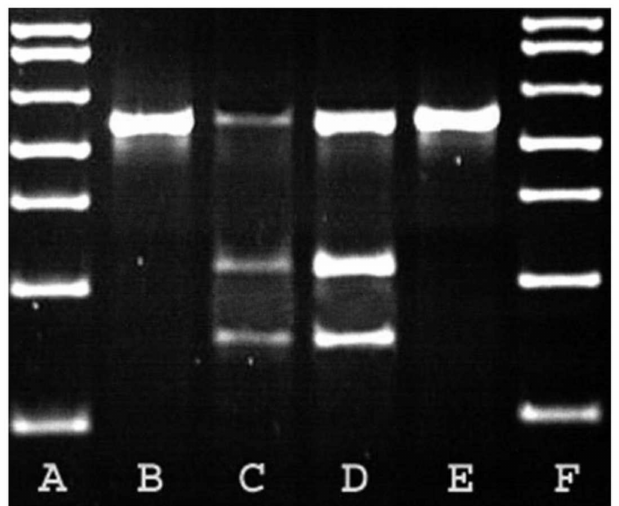
Figure 2. Restriction Fragment Length Polymorphism (RFLP) analysis for feline Polycystic Kidney Disease ( PKD1 ) mutation. B and E = unaffected cats, C and D = affected cats, A and F = molecular weight markers